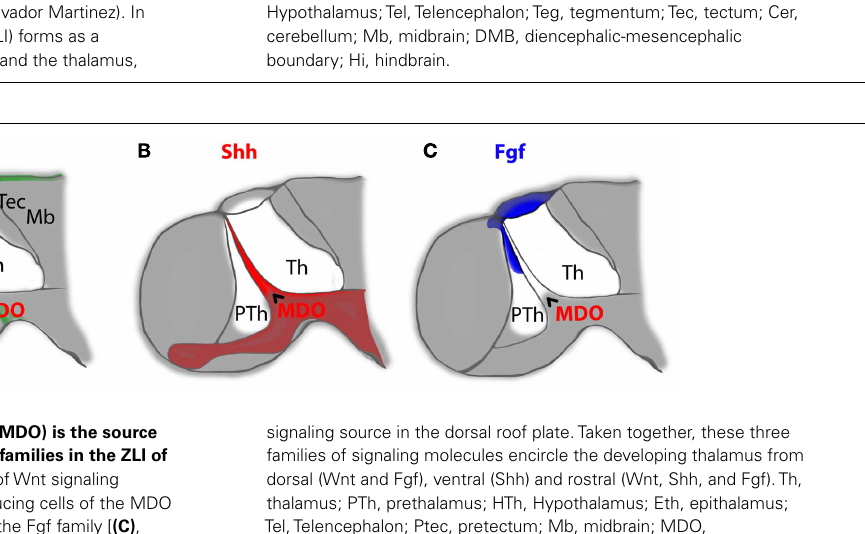
FIGURE 1 | Morphological comparison of embryonic brain regions in different vertebrate embryos. (A) Zebrafish 36hpf. (B) Chicken HH20. (C) Mouse 11.5dpf (with courtesy of Salvador Martinez). In vertebrates the zona limitans intrathalamica (ZLI) forms as a morphological ridge between the prethalamus and the thalamus,